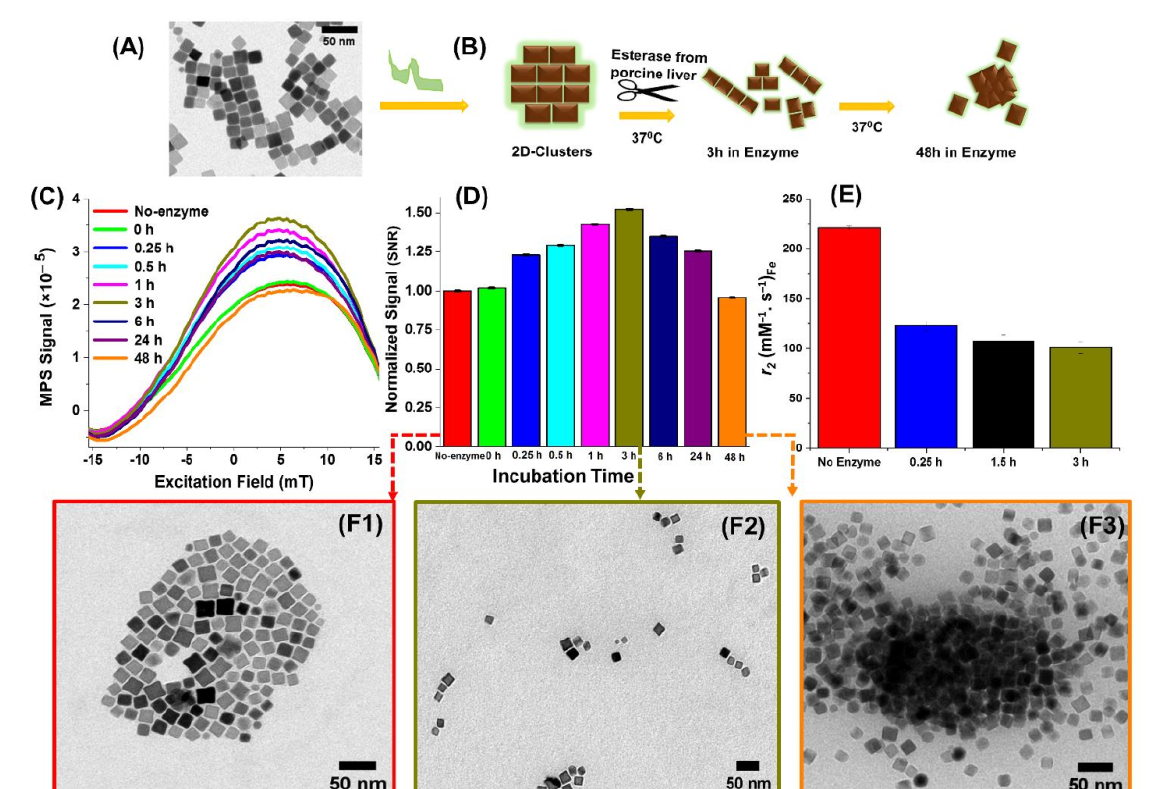
Figure 2. ( A ) Representative TEM image of iron oxide nanocubes used in the fabrication of the 2D-Clusters. ( B ) Schematic representation of the enzymatic incubation study of the 2D-Clusters in response to an esterase enzyme. ( C ) The progression of the PSF of the 2D-Clusters upon exposure to esterase at different time points for a total incubation period of up to 48 h, analyzed at 16 kHz and 20 mT, and ( D ) the histogram of the corresponding SNRs. ( E ) Magnetic resonance relaxation rates of the 2D-Clusters before and after exposure to the enzyme measured in water after exposure to 1.5 T of a static magnetic field. ( F1 – F3 ) TEM images of the initial 2D-Clusters ( F1 ) with no enzyme treatment and after a 3 h ( F2 ) and 48 h incubation ( F3 ) period with the esterase